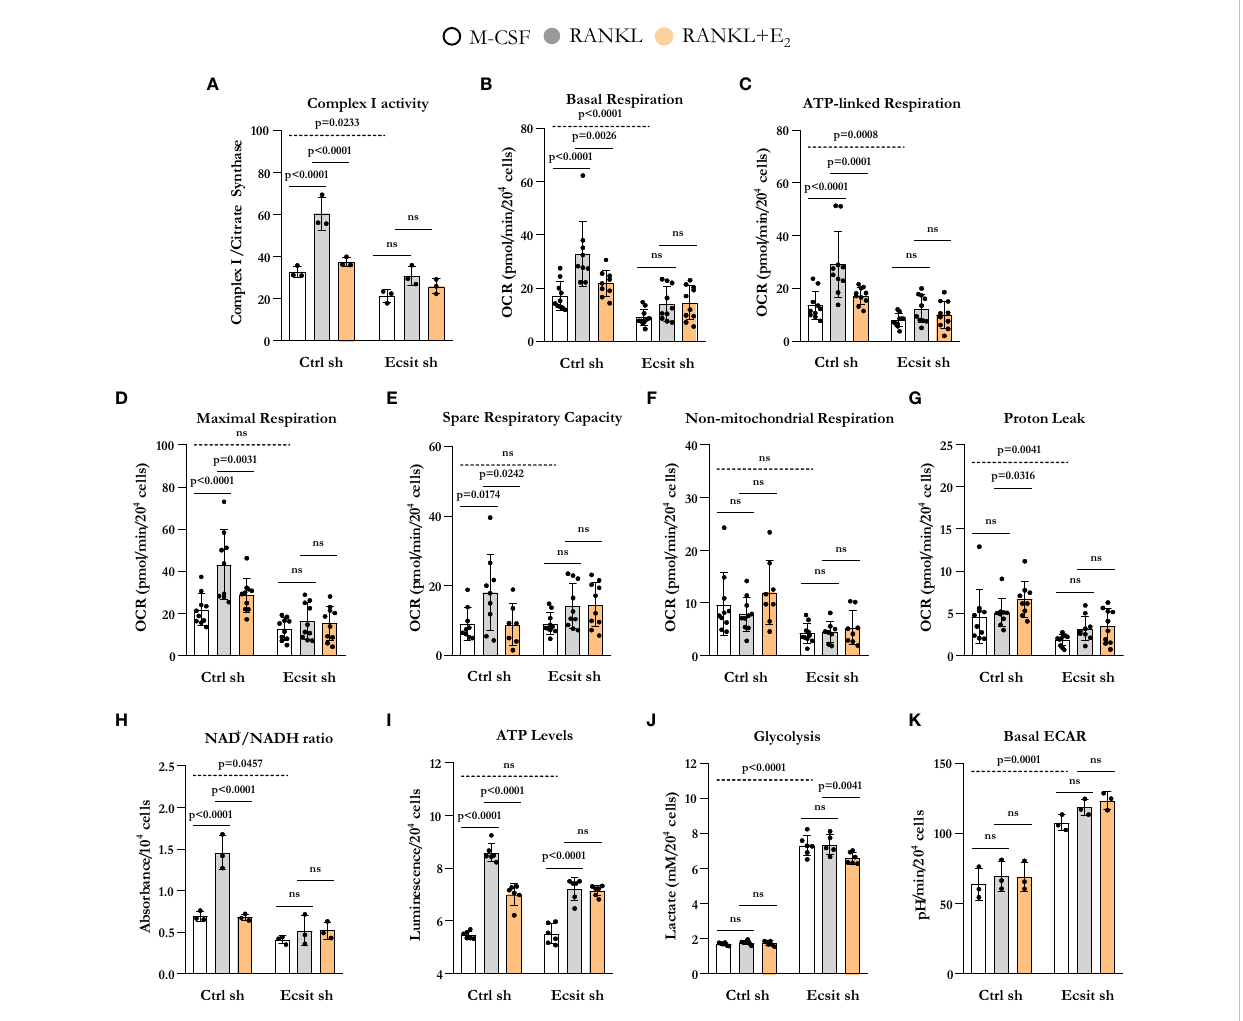
FIGURE 3 ECSIT silencing alters RANKL-stimulated mitochondria metabolism. BMMs were silenced with Ecsit sh (#2) or control (Ctrl) sh lentivirus particles. All assays were performed in cells cultured as indicated for 6 h. (A) Complex I activity was quanti fi ed based on the average of 3 replicates per treatment. (B – G) Different fractions of mitochondrial and non-mitochondrial respiration per cell measured with Seahorse; oxygen consumption rate (OCR). (H) NAD + /NADH ratio and (I) ATP levels (expressed as relative light units, RLU). (J) Lactate concentration in culture supernatants. (K) Basal extracellular acidi fi cation rate (ECAR). Bar graphs depict mean ± S.D. of 3-10 wells (black dots) of one representative experiment; p values analyzed by 2-way ANOVA. ns=not signi fi cant